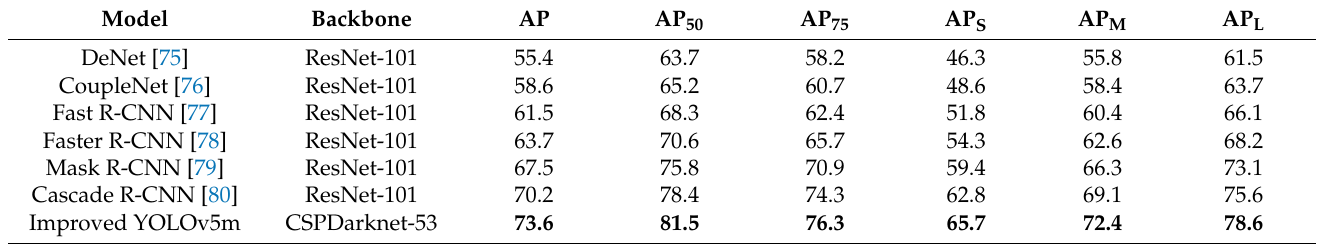
Table 9. The proposed method versus other two-stage object detectors on the custom wildfire smoke dataset test-set. Improved YOLOv5m achieves results that are competitive with two-stage object Table 10. The proposed method versus other one-stage object detectors on the custom wildfire smoke detectors. dataset test-set. Improved YOLOv5m outperforms all one-stage object